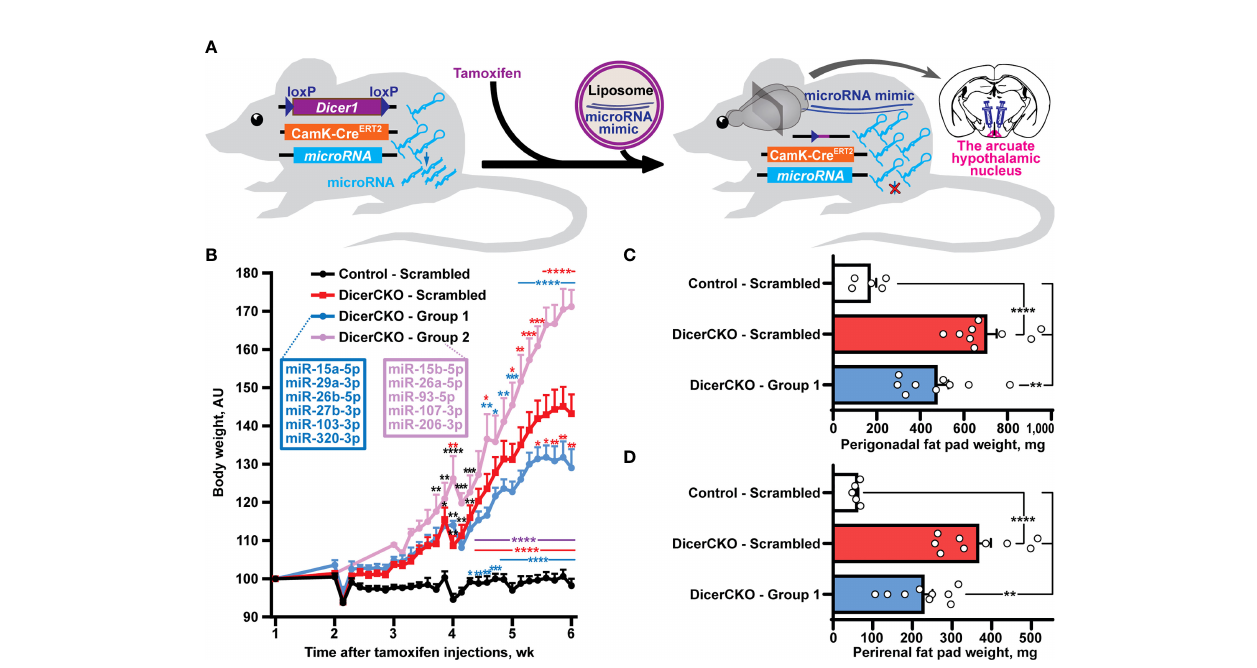
FIGURE 1 | Reductionist approach to identify microRNAs attenuating obesity phenotype caused by neuronal Dicer1 depletion. (A) Scheme of the experiment to deliver liposomal formulations of microRNA mimics mixtures into the arcuate hypothalamic nucleus (ARH) of mice with a depletion of Dicer1 in the forebrain neurons. (B) Body weight dynamics in DicerCKO mice injected by the indicated LNA-stabilized microRNAs mimics Group 1 and Group 2 or scrambled oligonucleotides, and control mice (n = 9, 4, 9 and 5, respectively). (C,D) Weight of perigonadal (C) and perirenal (D) fat pads from DicerCKO mice injected by the microRNAs mimics Group 1 or scrambled oligonucleotides, and control mice (n = 9, 9 and 5, respectively). Error bars represent standard error of means (SEM). * p < 0.05; ** p < 0.01; *** p < 0.001; **** p < 0.0001 vs. groups indicated by respective colors, as assessed by 2-way ( B , F (23, 438) = 44.9, F (3, 438) = 323.4 and F (69, 438) = 6.3 for time, experimental group and interaction factors) or 1-way ( C, D , F (2, 20) = 21.47 and 24.57, respectively) ANOVA followed by Holm-S ̌ ı ́ da ́ k pairwise comparison